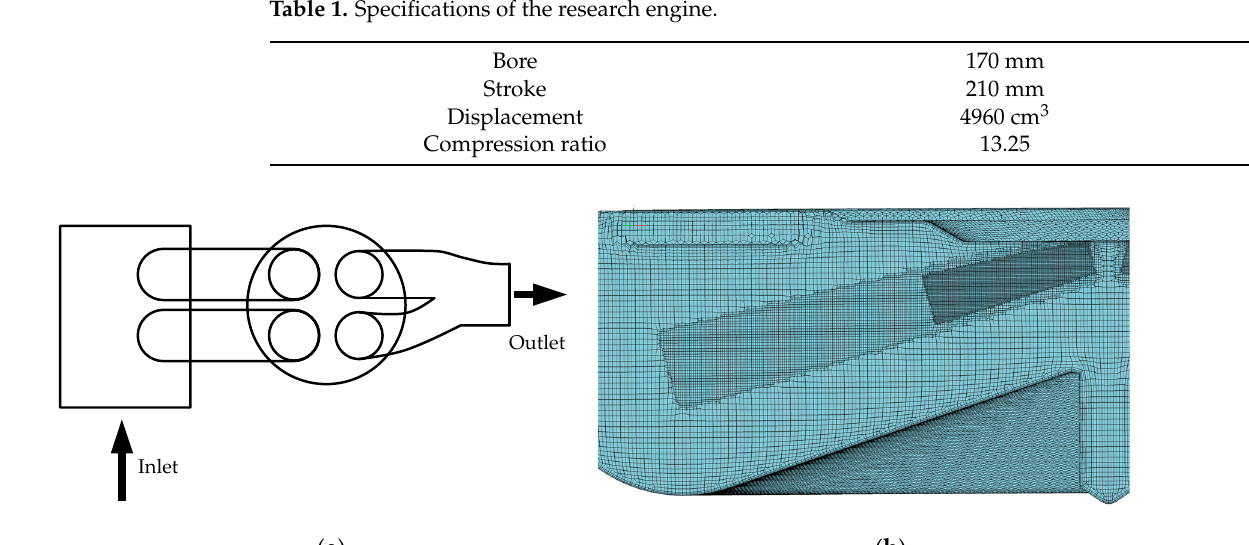
Figure 1. ( a ) Schematic diagram of the engine geometry covered by the computational mesh. ( b ) Plane cut through the implemented spray refinements.